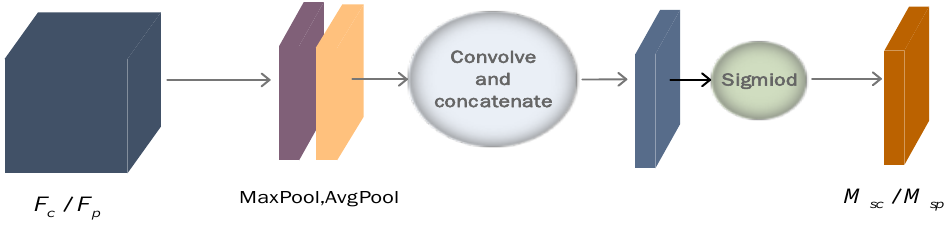
Figure 6. Spatial attention module . (3) FPN architecture. P − P in the FPN structure were obtained from the convolu- The feature maps 3 7 tional layer through one convolutional layer to obtain feature map